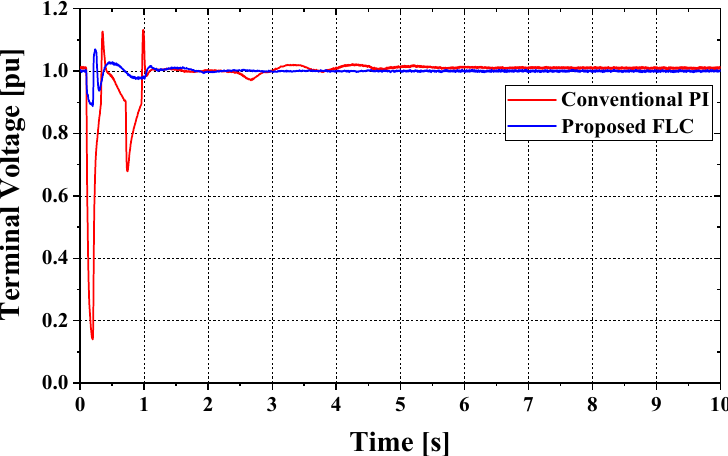
Figure 9. Terminal voltage profile of the conventional and proposed PV plants at bus 10.